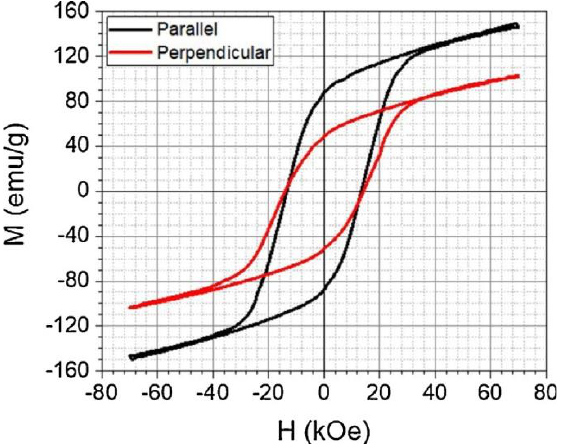
Figure 13. Magnetic characterization of Nd-Fe-B + Sm-Fe-N/Nylon12 65 vol% sample aligned at 230 °C nozzle temperature and 1.5 A alignment current. Reprinted from [103], copyright (2020), with permission from Elsevier.